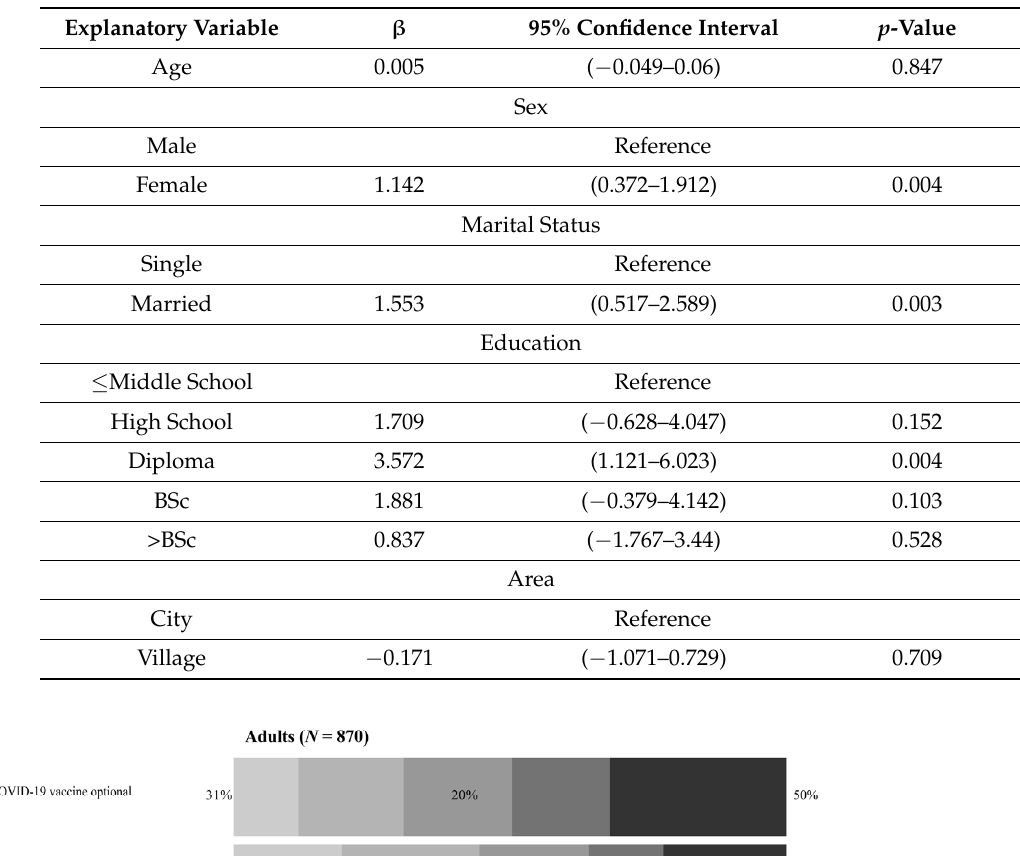
Table 2. Parameter estimates of the demographic variables from ordinary least squares regression on worry about COVID-19 vaccines among adults ( N = 870).